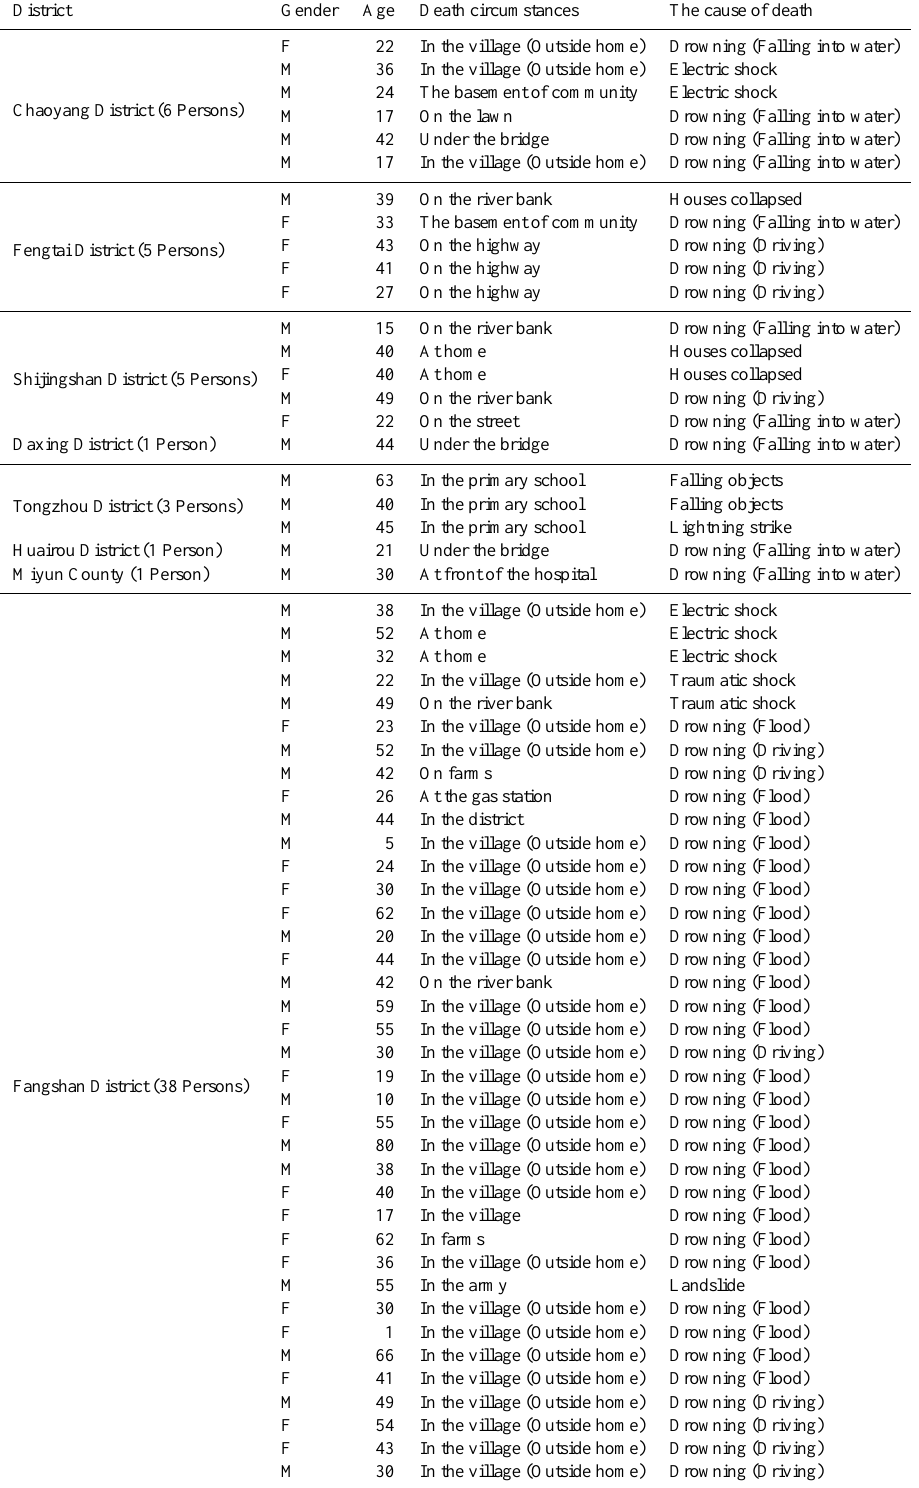
Table 2. Summary of victims’ characteristics from the extreme rainfall event in Beijing on 21–22 July 2012. District